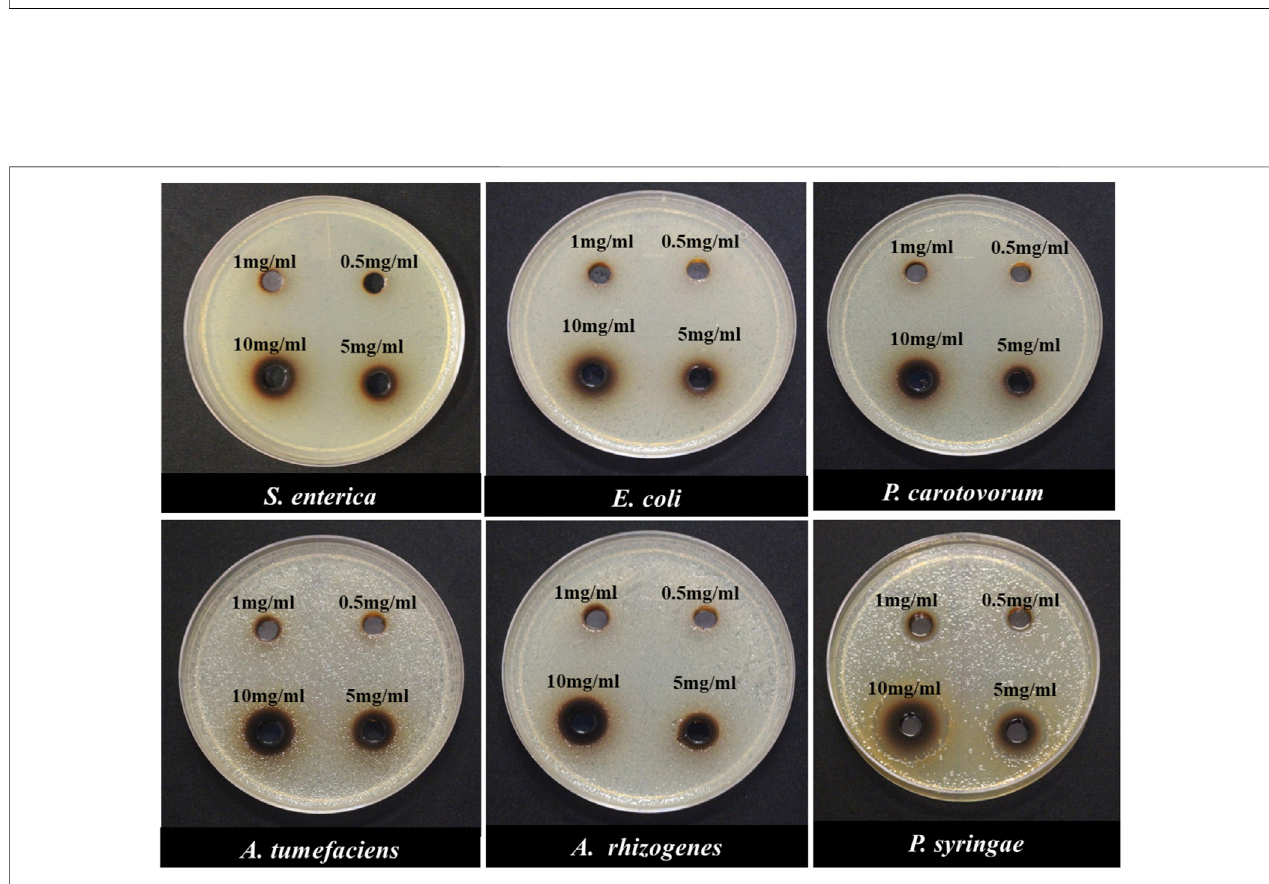
FIGURE 4 | Minimum inhibitory concentration (MIC) of Gram-negative bacterial species in response to different concentrations of NH2-FCDs using the agar-plate well diffusion method.